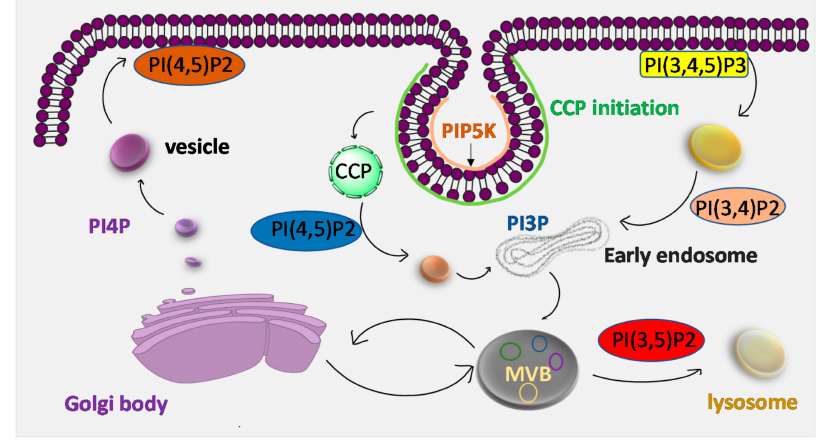
Figure 7. PIP 2 is involved in intracellular tra ffi cking and vesicular transport. PIP 2 participates in both clathrin mediated (CCP) and non- clathrin mediated endocytosis. PI(3,5) P 2 is involved in exocytosis whereas PI(4,5) P 2 and PI(3,4) P 2 are involved in endocytic